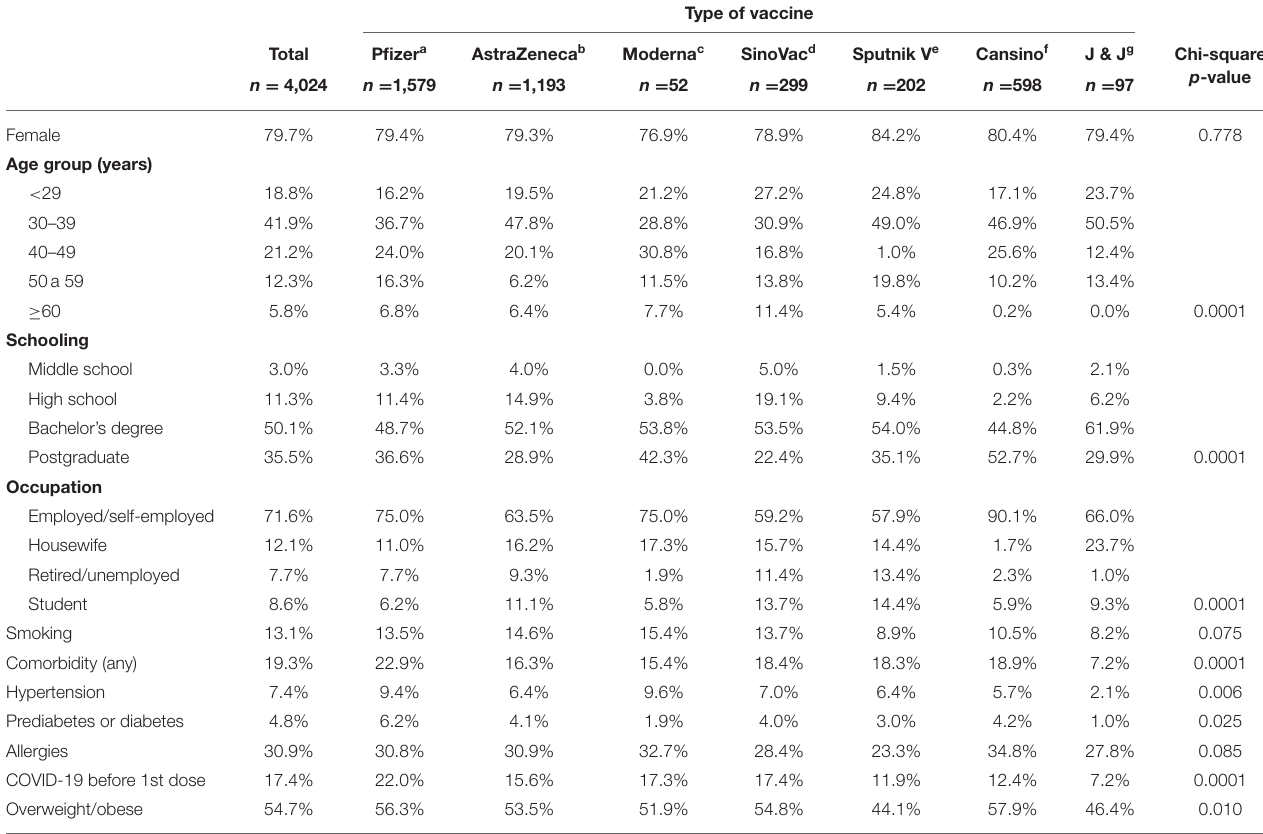
TABLE 2 | Sociodemographic, comorbidity, and other